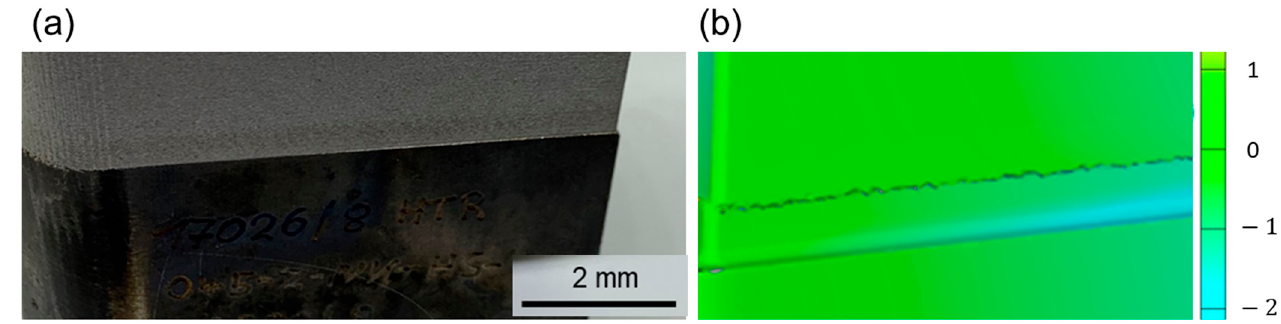
Figure 13. ( a ) Repaired 1.2343/H11 Tool. ( b ) 3D GOM Scan of the interface. The scale is shown in mm.